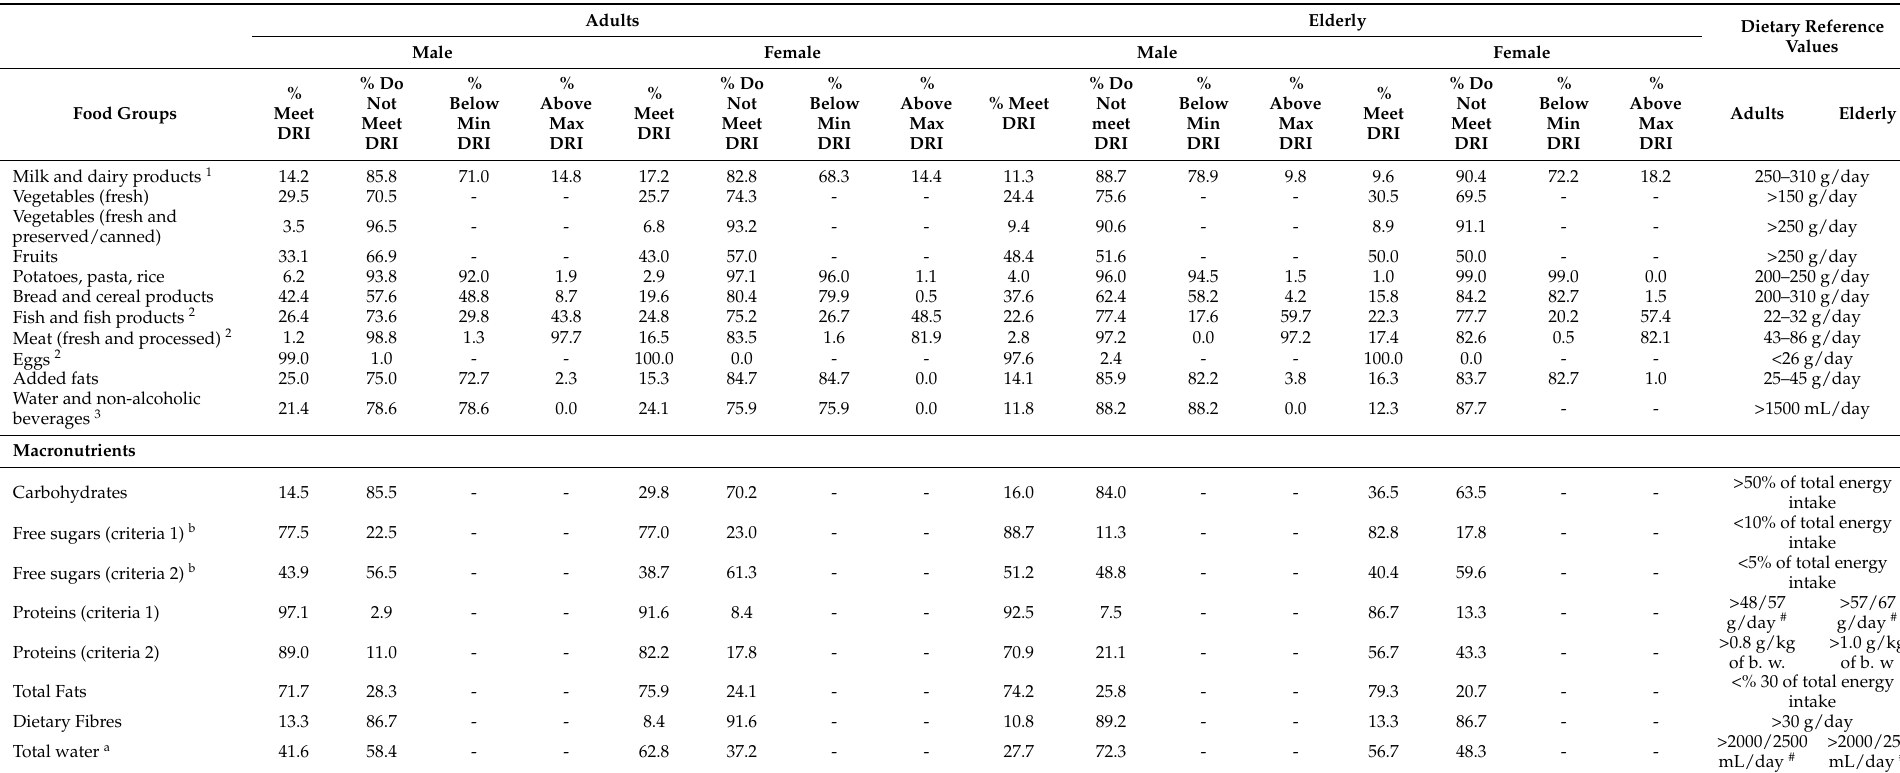
Table 6. Proportion (%) of the study population meeting reference values for intake of specific food groups, nutrients, dietary fibre, and water. Adults Elderly Dietary Reference ValuesMale Female Male